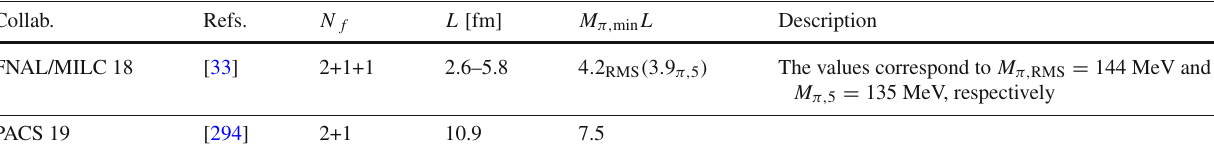
Table 105 Finite-volume effects in determinations of f + ( 0 ) . The subscripts RMS and π, 5 in the case of staggered fermions indicate the root- mean-square mass and the Nambu–Goldstone boson mass, respectively Collab.